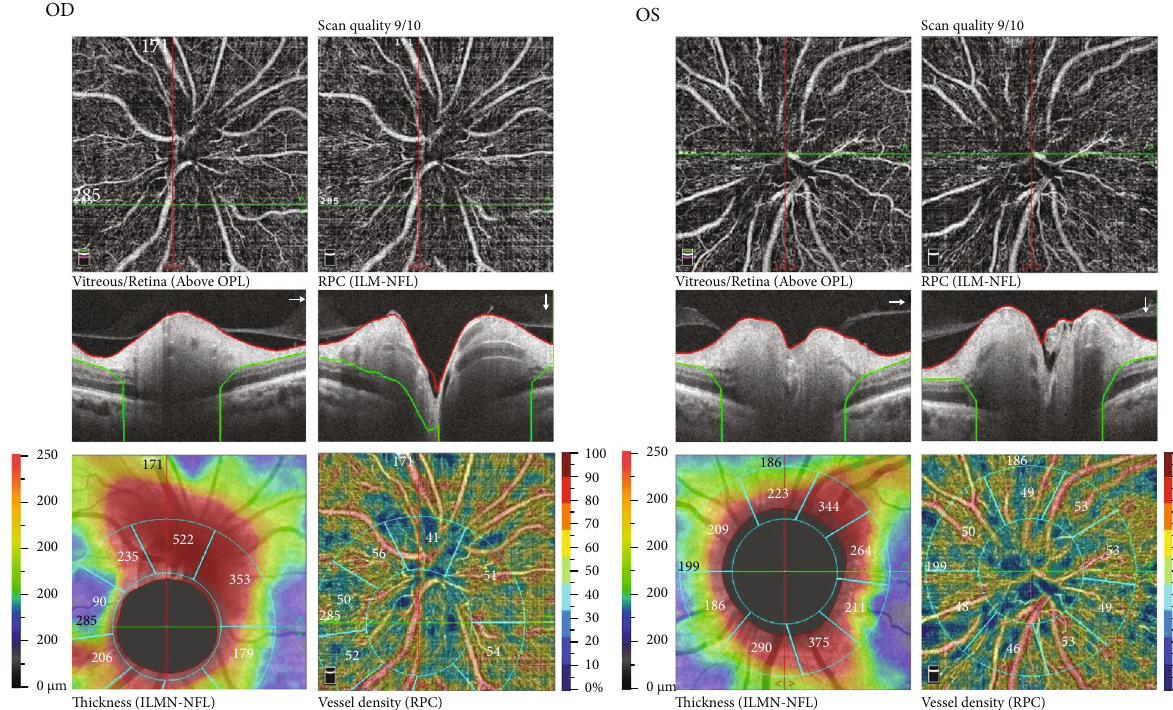
Figure 4: OCT-A of the right and left eyes showing peripapillary distortion of the retinal nerve fi ber layer and pronounced loss of the capillary microvascular